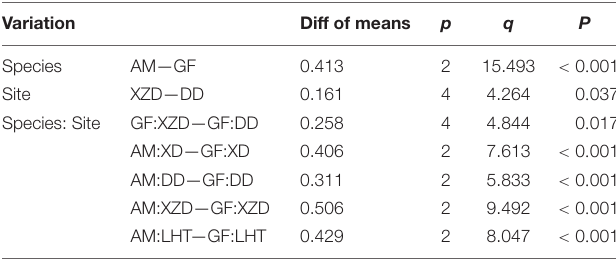
TABLE 2 | Significant results of Tukey HSD test to assess the effect of coral species, site, and coral species: site on MPs abundance in corals. Variation Diff of